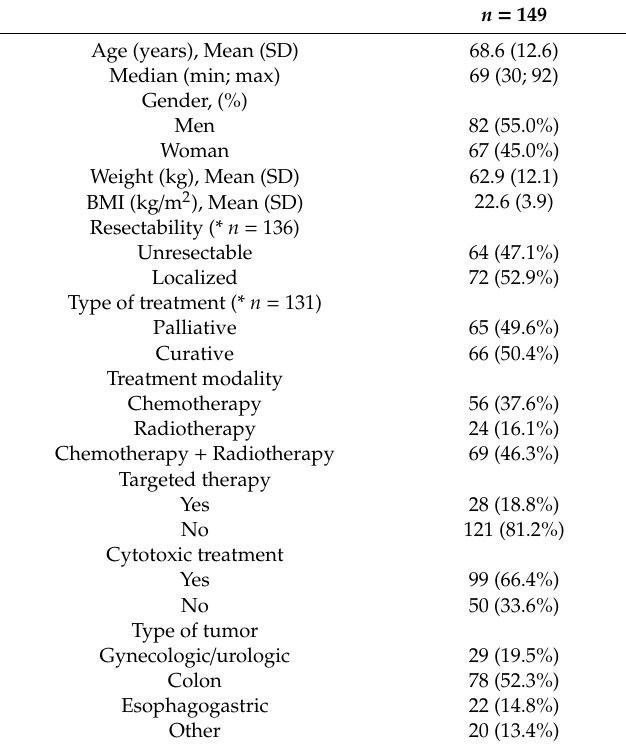
Table 1. Demographic and clinical characteristics of study